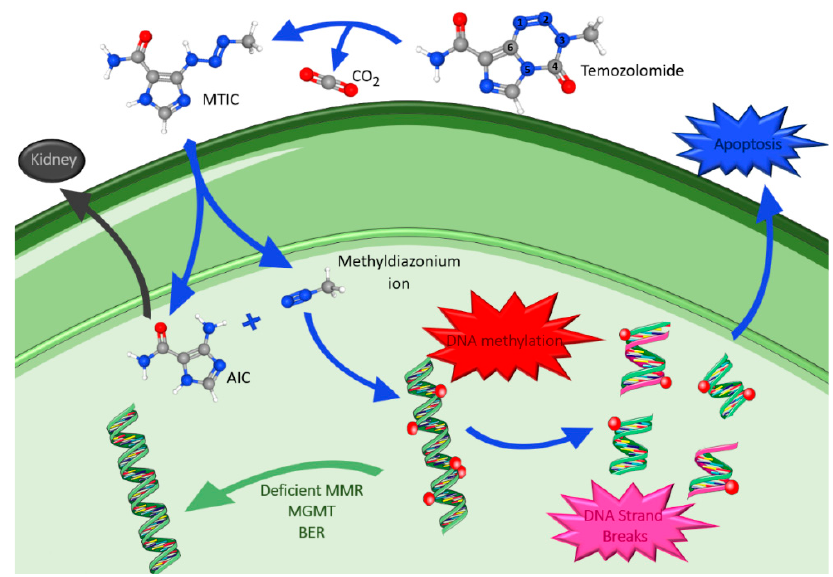
Figure 3. Temozolomide metabolism, mechanism of action and drug resistance. Atom color code: blue, nitrogen; grey, carbon; red, oxygen; white, hydrogen. Figure drawn with smart.servier.com and using molecules from PubChem [68–72].